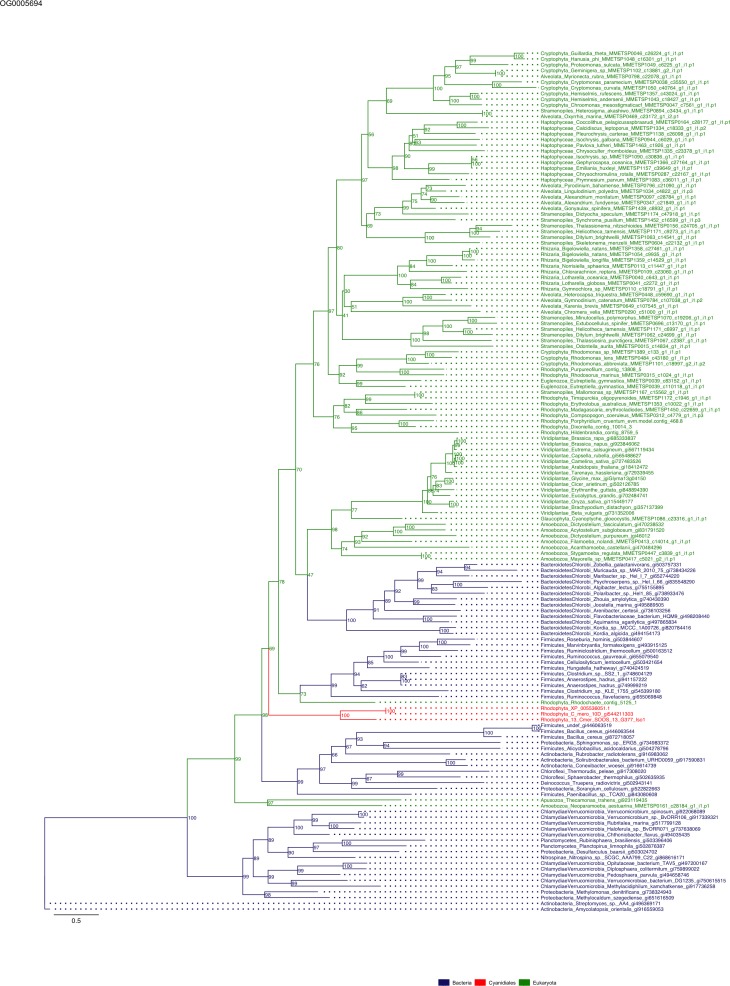
Sequence tree of orthogroup OG0005694.The tree is based on amino acid sequences. Archaea (yellow), Bacteria (blue), Cyanidiales (red), Eukaryotes including other red algae (green). Branches containing Cyanidiales sequences are highlited in red.